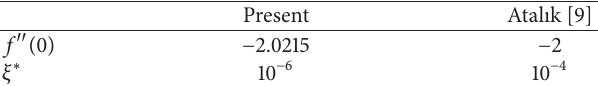
Table 2: Comparison of 𝑓 󸀠󸀠 (0) and 𝜉 ∗ for C =